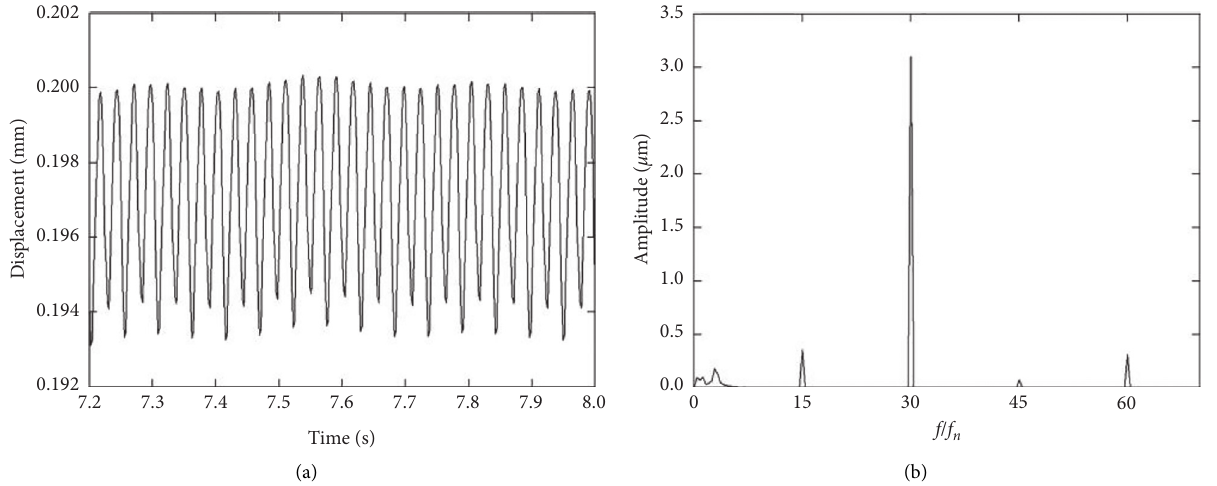
Figure 12: Displacement fluctuation analysis of the extreme dynamic displacement point ( A ). (a) Time-domain graph. (b) Frequency- domain graph.